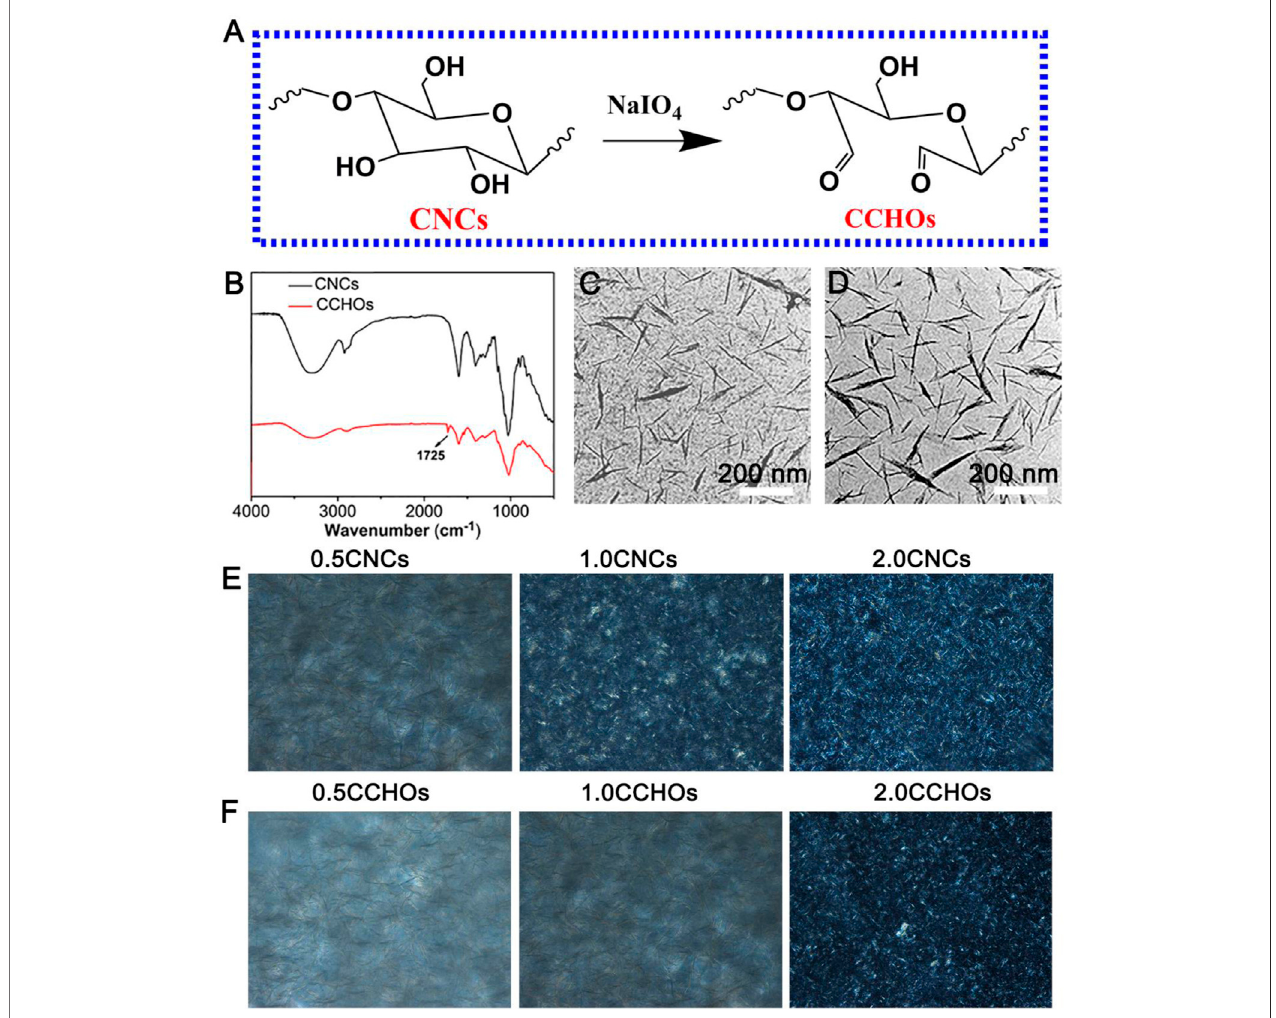
FIGURE 1 | (A) Schematic of synthesis of CCHOs. (B) FTIR spectra of the CNCs and CCHOs. TEM image of CNCs (C) and CCHOs (D) . The corresponding POM images of CNC (E) and (F) CCHO whisker aqueous suspensions with 0.5, 1, and 2% concentrations.